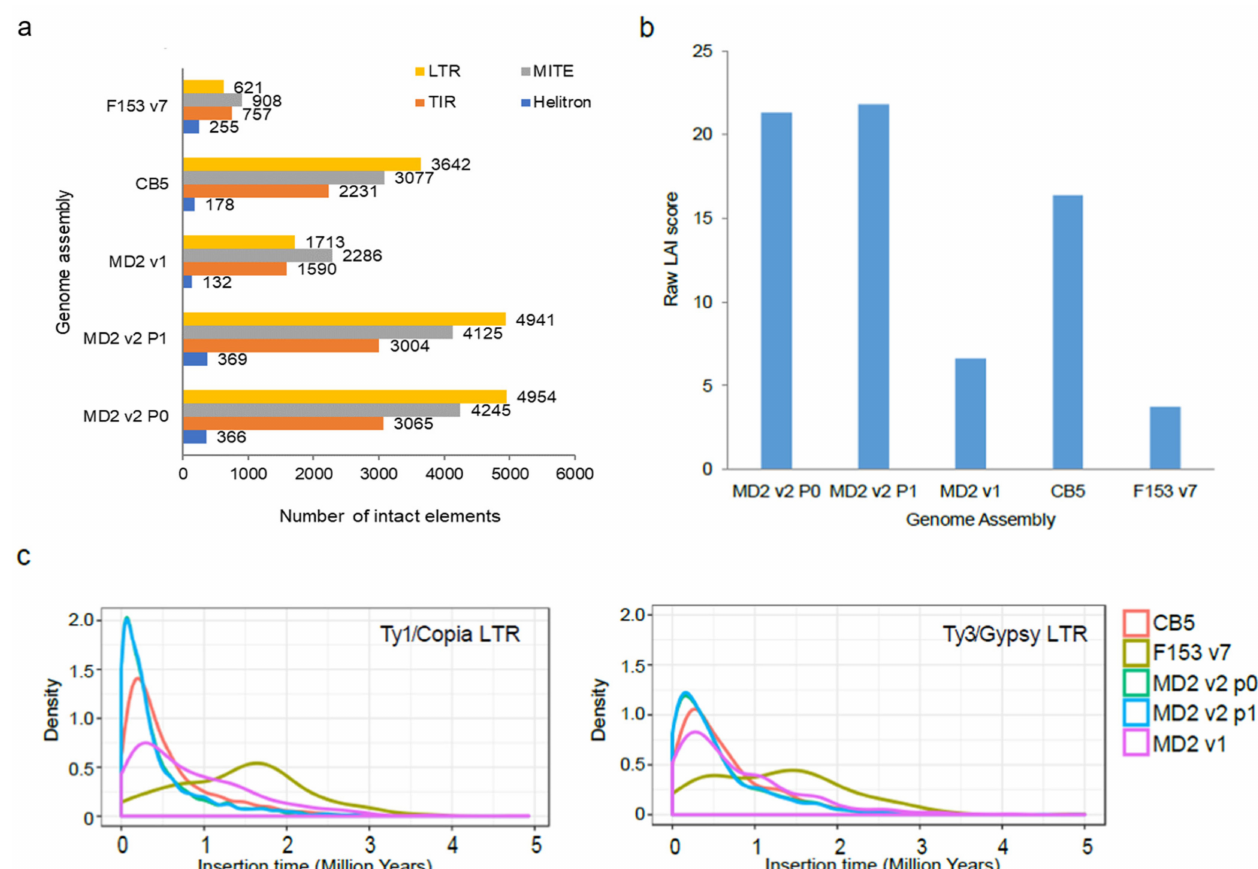
Figure 2. Annotation of repetitive sequences in MD2 v2 and other pineapple genomes (MD2 v1, F153 v7, and CB5). ( a ) Intact transposable elements (TEs) assembled in each pineapple genome; ( b ) Raw LTR Assembly Index (LAI) score for each pineapple genome. The LAI score is calculated as the ratio of intact elements to total elements in the assembly; therefore, a higher LAI score indicates a higher quality assembly with a larger proportion of intact elements assembled; ( c ) Insertion time for Ty3/Gypsy LTR and Ty1/Copia LTR elements in pineapple genomes. Lower insertion time indicates more recent origin. Density was calculated using the function geom_density from ggplot2 using the insertion time of all intact elements in million